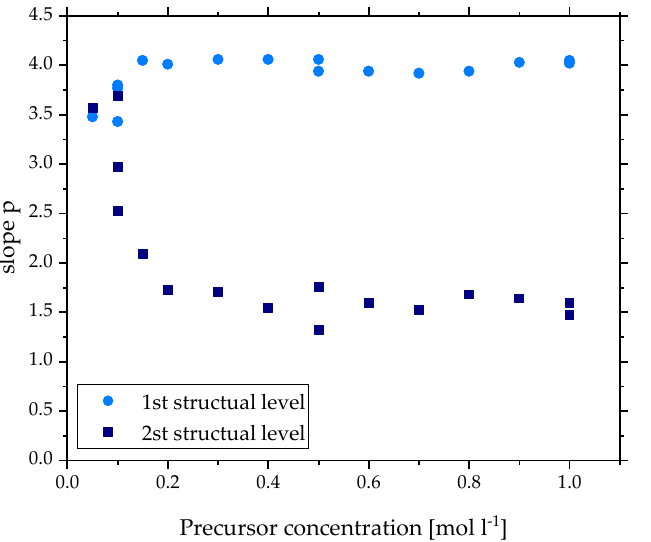
Figure 8. Slope p of the power law fit from SAXS scattering data for both structural levels of zirconia made by SFS with different precursor concentrations.